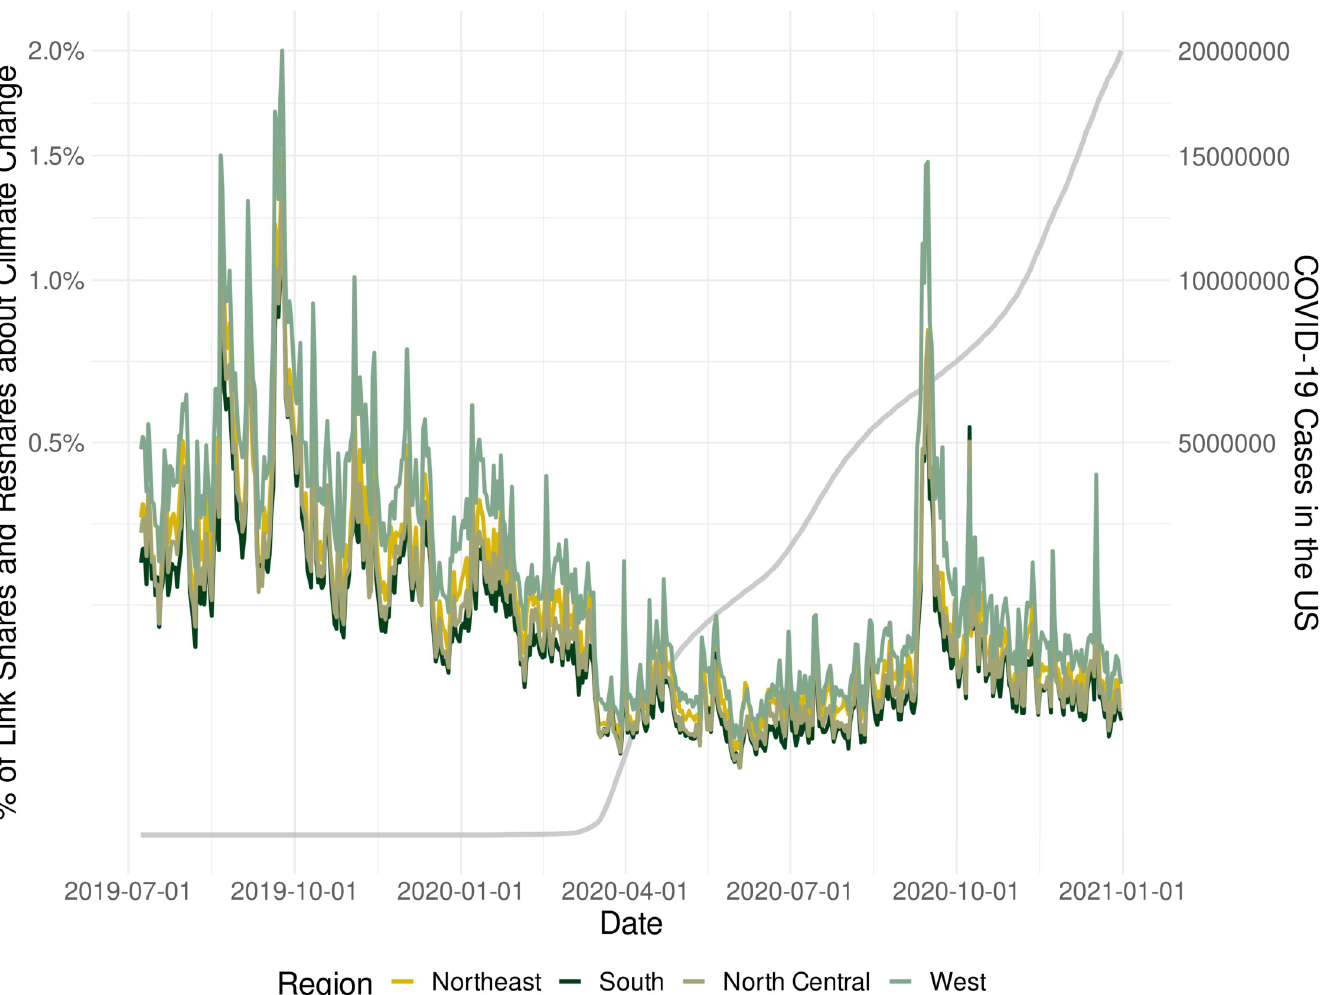
Fig 1. Percentage of climate change link shares and reshares relative to all shares and reshares in the United States.